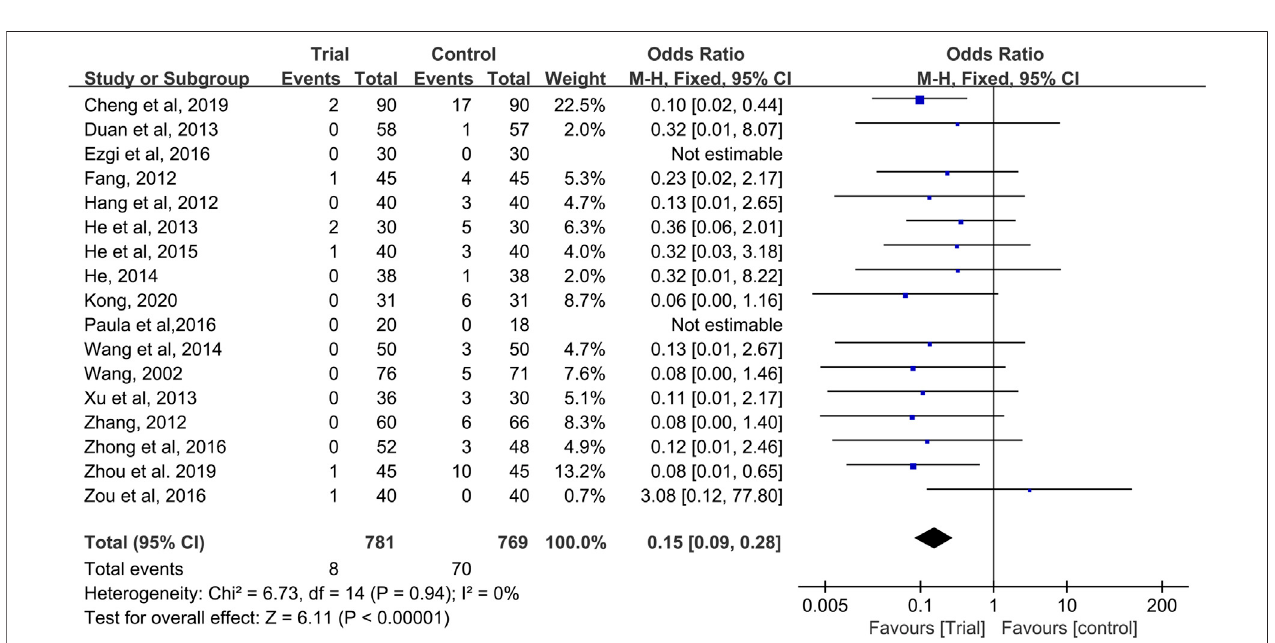
FIGURE 5 | Forest plots of incidence of grade III-IV CIOM.